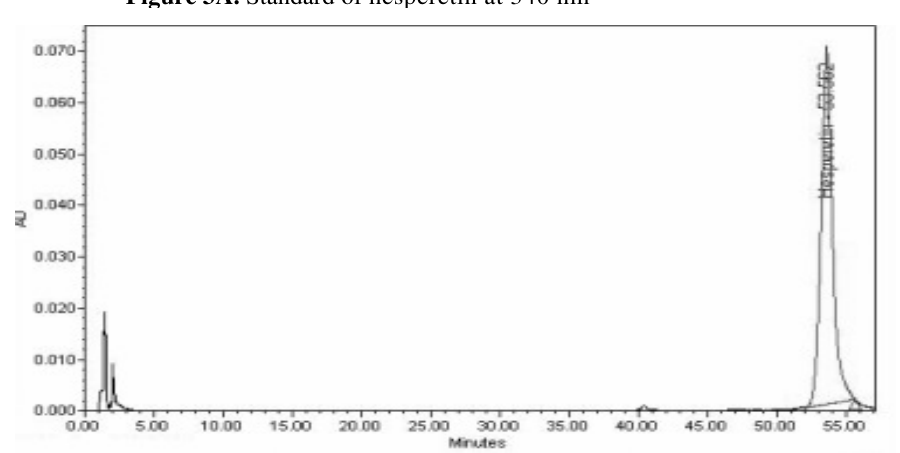
Figure 3A. Standard of hesperetin at 340 nm